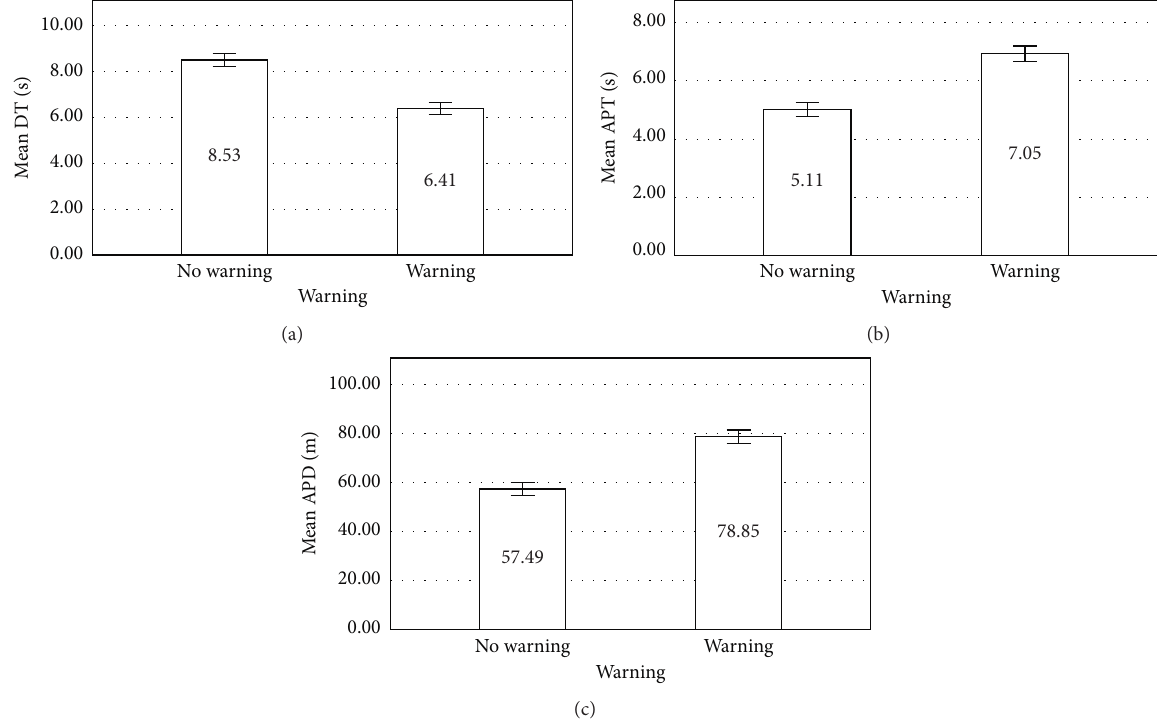
Figure 7: Fitted mean profiles of DT, APT, and APD with respect to different levels of factors. (a) DT. (b) APT. (c) APD.